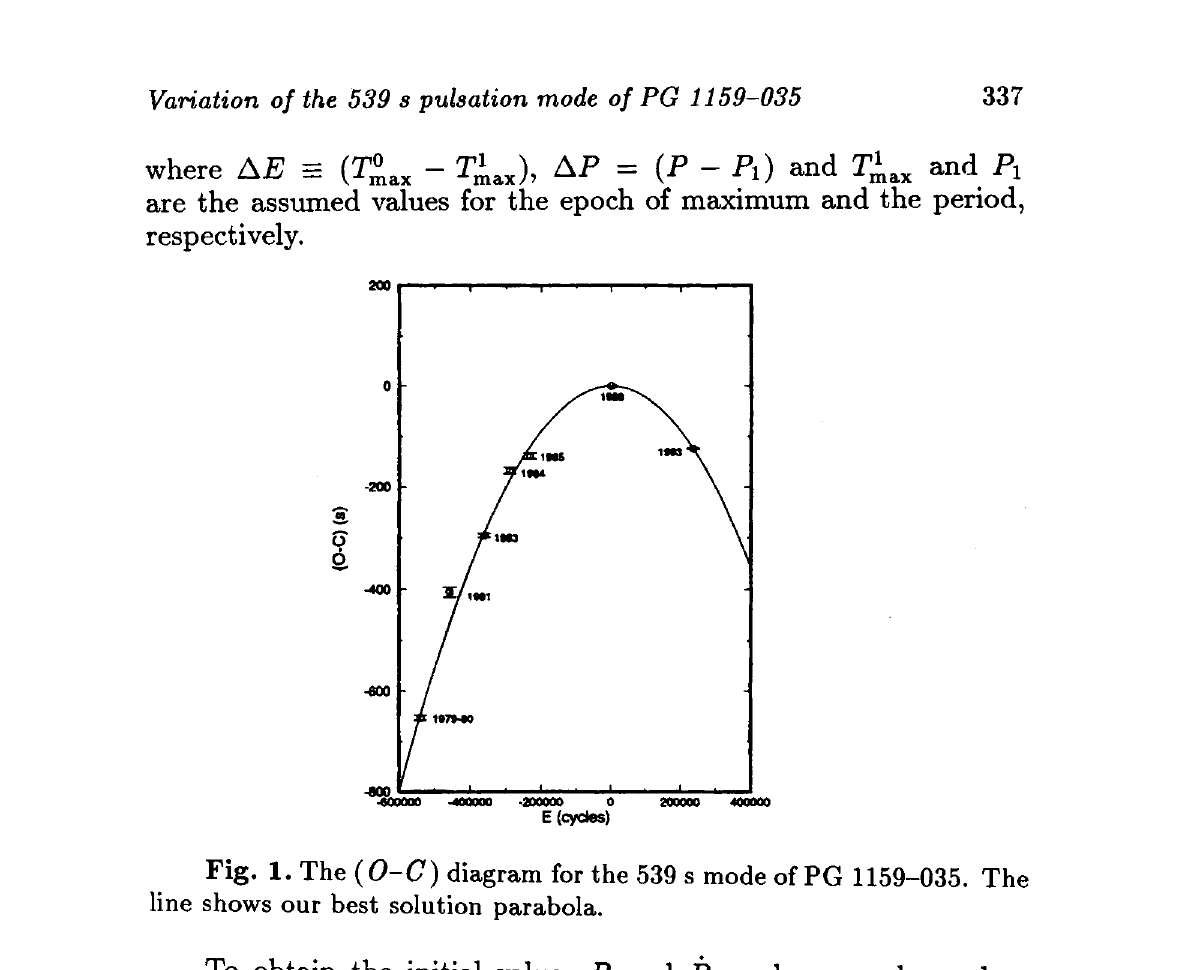
Fig. 1. The ( 0 - C) diagram for the 539 s mode of PG 1159-035. The line shows our best solution